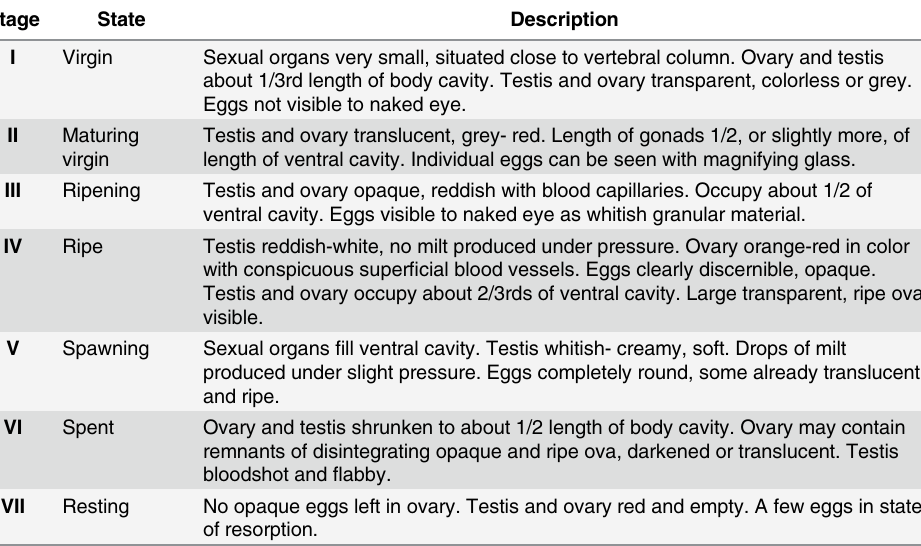
Table 1. A brief description of the maturity stages according to [15], used in this study.